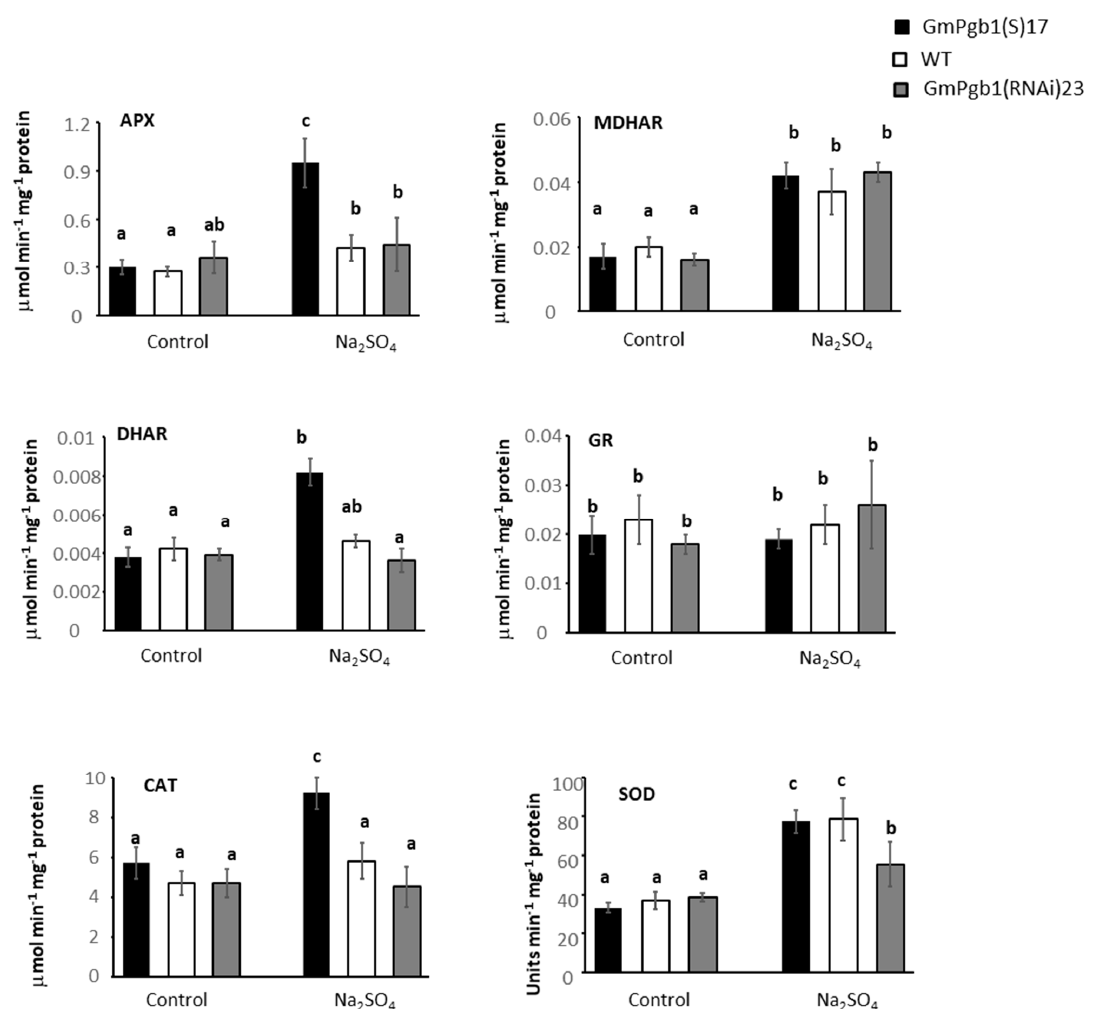
Figure 7. Enzymatic activity of ascorbate peroxidase (APX), monodehydroascorbate reductase (MDHAR), dehydroascorbate reductase (DHAR), glutathione reductase (GR), catalase (CAT), and superoxide dismutase (SOD) in soybean plants exposed to Na 2 SO 4 . Measurements were taken in the WT line and the lines overexpressing (GmPgb1(S)17) or downregulating (GmPgb1(RNAi)23) GmPgb1 . Values are the means ± SE of three biological replicates, each consisting of at least three plants. Letters indicate statistically significant differences ( p < 0.05).